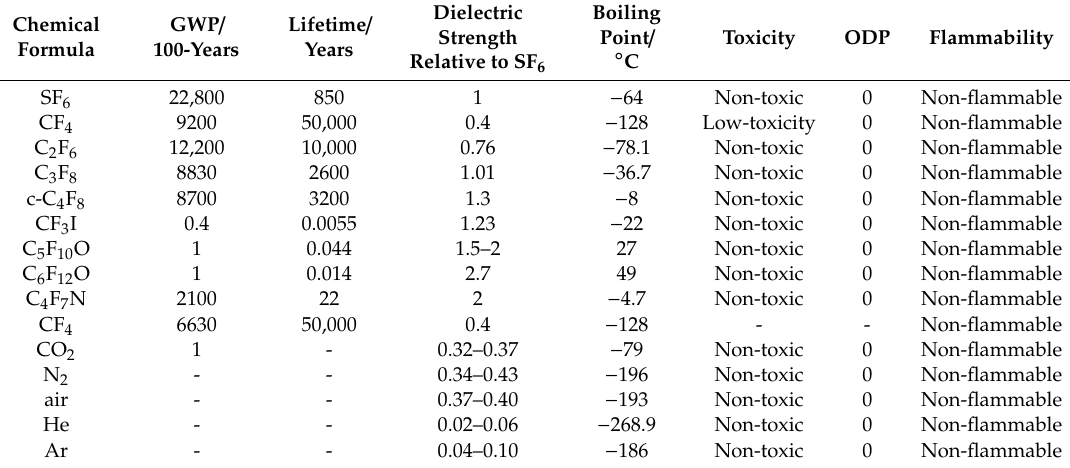
Table 1. Basic properties of compounds used in electrical insulation. GWP: global warming potential; ODP: ozone depletion